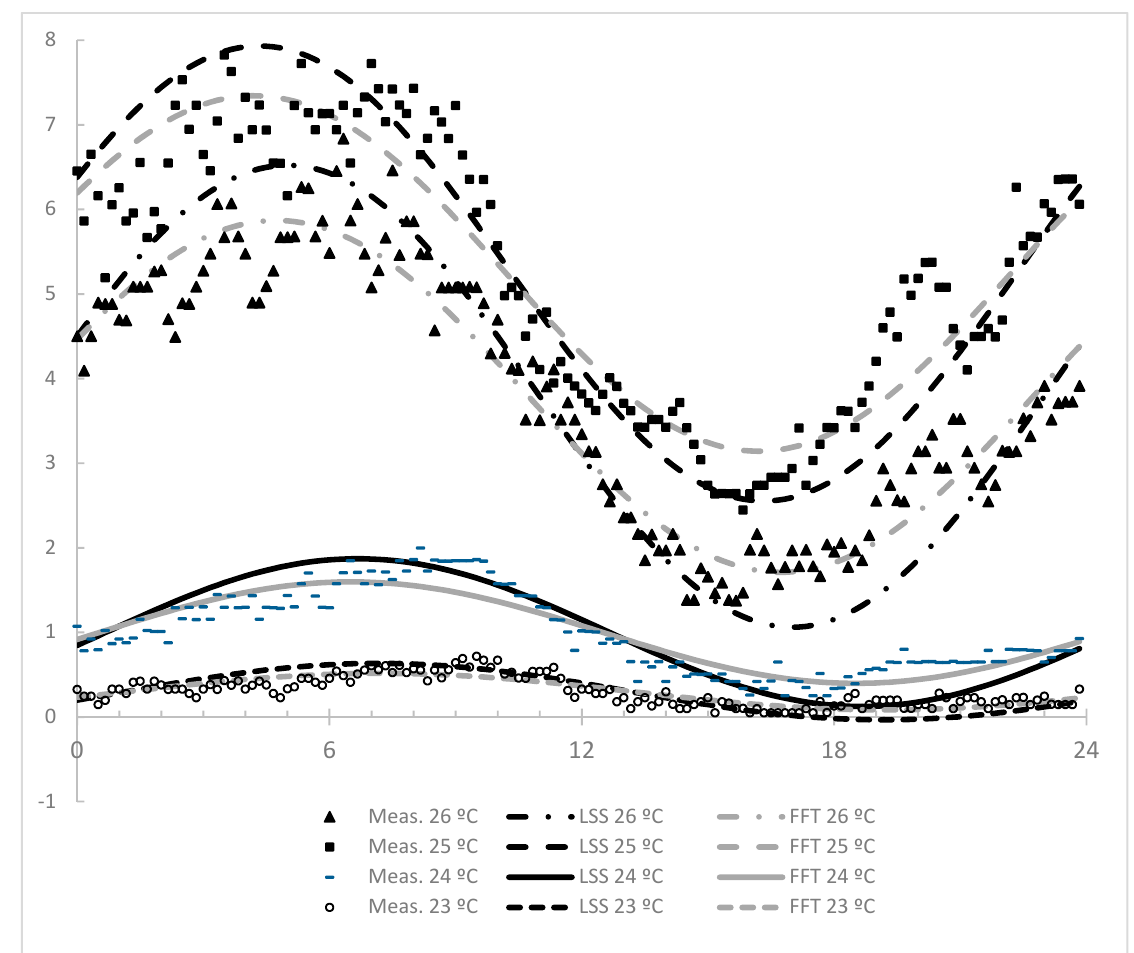
Figure 5. Measured (Meas.) and modeled sine fit using least squares setting (LSS) and fast Fourier transform (FFT) for daily evolution of NH 3 concentration at different setpoint temperatures.